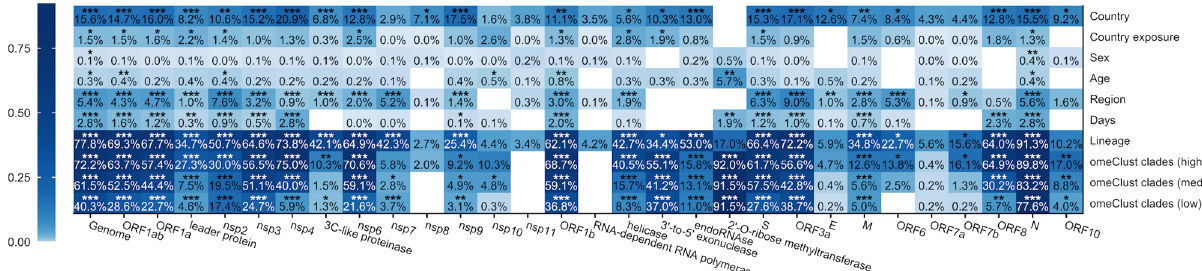
Figure 4. Association between SARS-CoV-2 genome regions and metadata. Distances among CoV genomes and 29 specific regions using GTR + G-based distances were used to assess relationships between variation explained between proteins, regions, and the whole genome of SARS-CoV-2 using paired measurements with differences across subjects by omnibus (PERMANOVA) test. White cells refer to scenarios where there was not sufficient variation to perform our analyses.